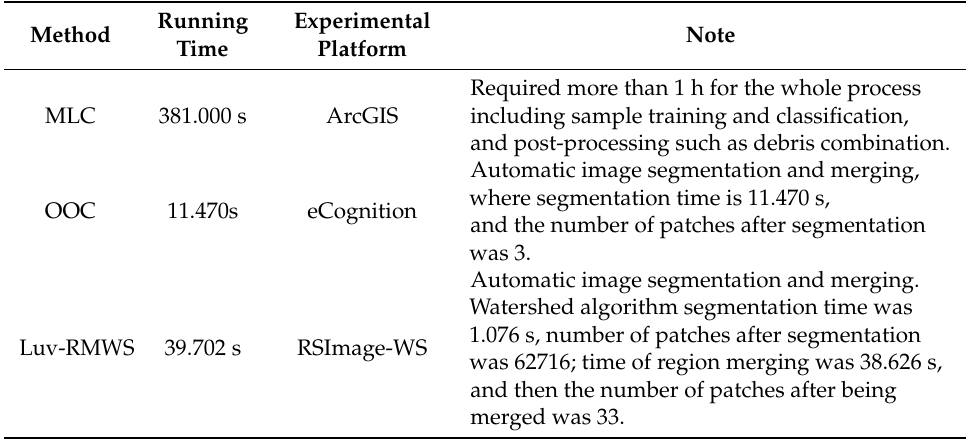
Table 3. Comparison of extraction times of unstable slope boundaries in experimental images.